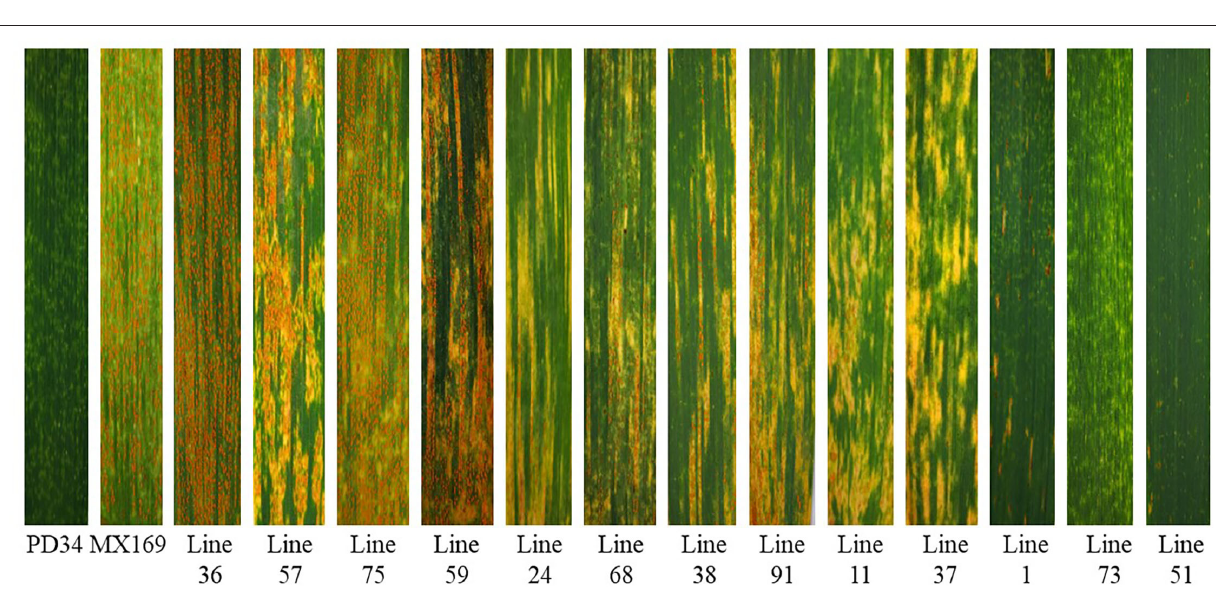
FIGURE 2 | Stripe rust reactions on the leaves of resistant parent Pindong 34 (PD), susceptible parent Mingxian 169 (MX), and representative stripe rust reactions of some of the recombinant inbred lines